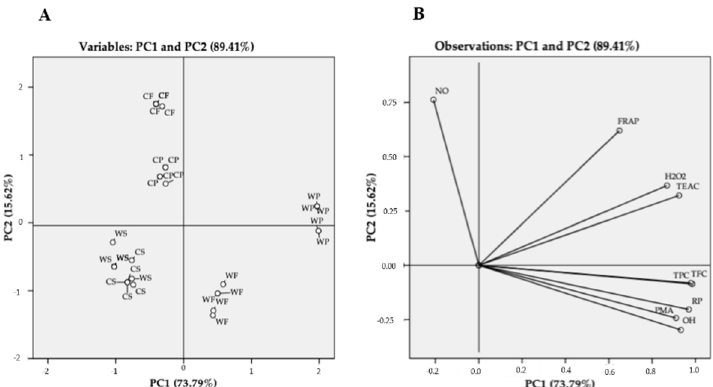
Figure 5. Projection of Opuntia sp. extracts ( A ) [variables: Wild seeds (WS), Cultivated seeds (CS), Wild pulp (WP), Cultivated pulp (CP), Wild fruit (WF), Cultivated fruit (CF)] and loadings ( B ) by chemical composition and bioactivities [variables: total phenolic content (TPC), total flavonoid content (TFC), Trolox equivalent antioxidant capacity (TEAC), reducing power (RP), Ferric reduc- ing antioxidant power (FRAP), Phosphomolybdenum antioxidant activity (PMA), Hydrogen per- oxide scavenging activity (H 2 O 2 ), Nitric oxide scavenging ( • NO), Hydroxyl radical scavenging (OH)] into the plane composed by the principal components PC1 and PC2 containing 89.41% of the total